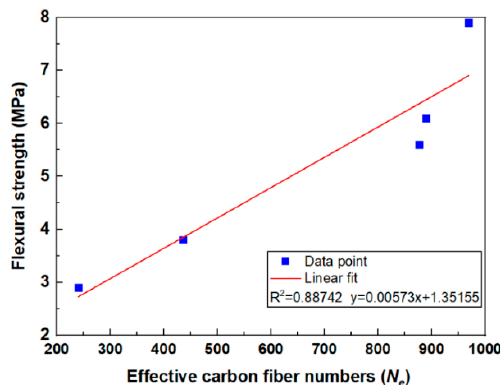
Figure 18. Relationship between the flexural strength of the composites and effective carbon fiber numbers.